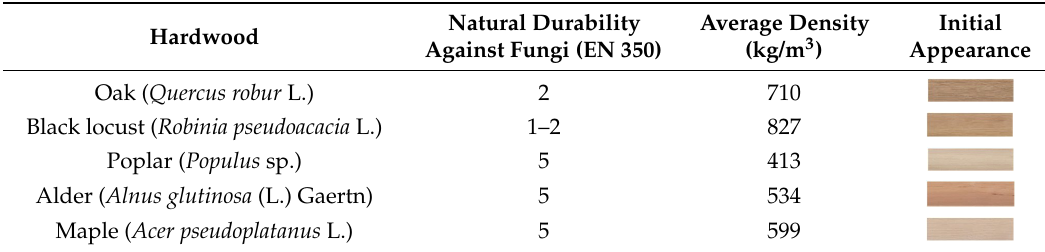
Table 1. Specification of used hardwoods. Natural durability against fungi is given in the range of 1–5, where 1 signifies the best durability. Wood density was determined at 12% wood moisture according to ČSN 49 0108 [40]. Hardwood Oak ( Quercus robur L.) 710 Black locust ( Robinia pseudoacacia L.) Poplar ( Populus sp.) Maple ( Acer pseudoplatanus L.)